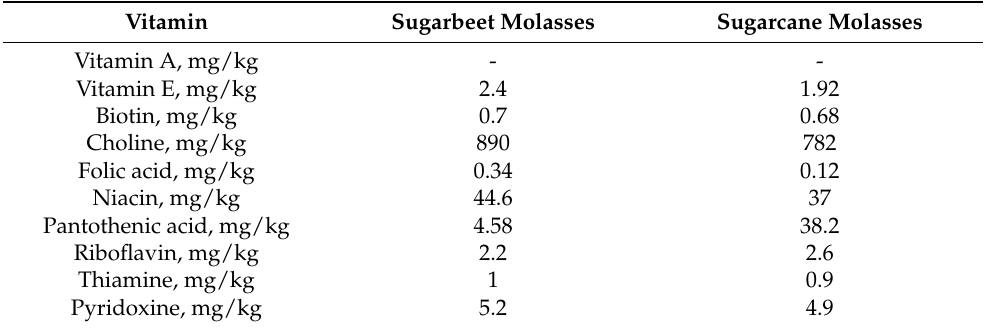
Table 5. Vitamin content of sugar beet and sugar cane molasses (modified from raw material compendium. 1994.